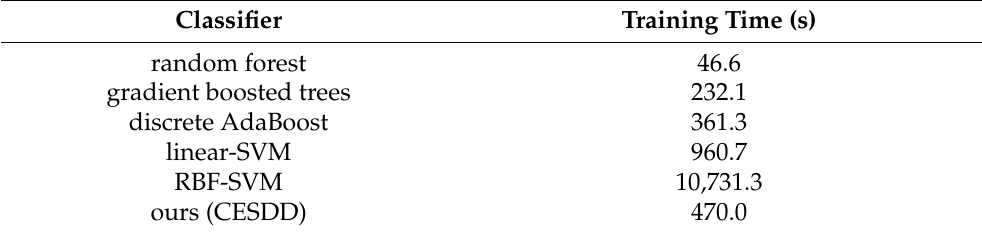
Table 2. Training time comparison of CESDD-based classifier and other classifiers.